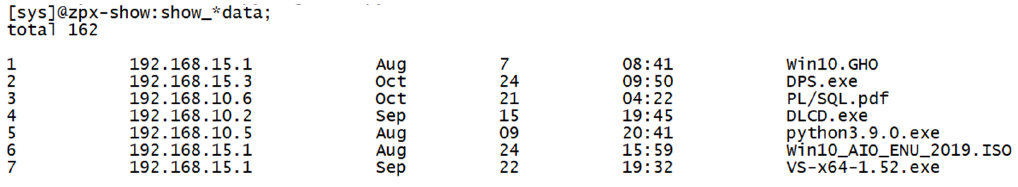
Figure 10. Files of all organizations.